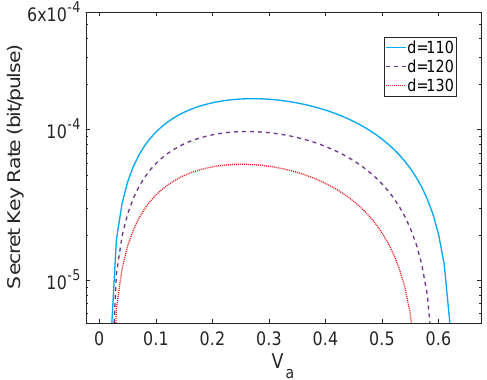
Figure 2. When (cid:101) = 0.01, the relationship between V a and secret key rate with different values of d .